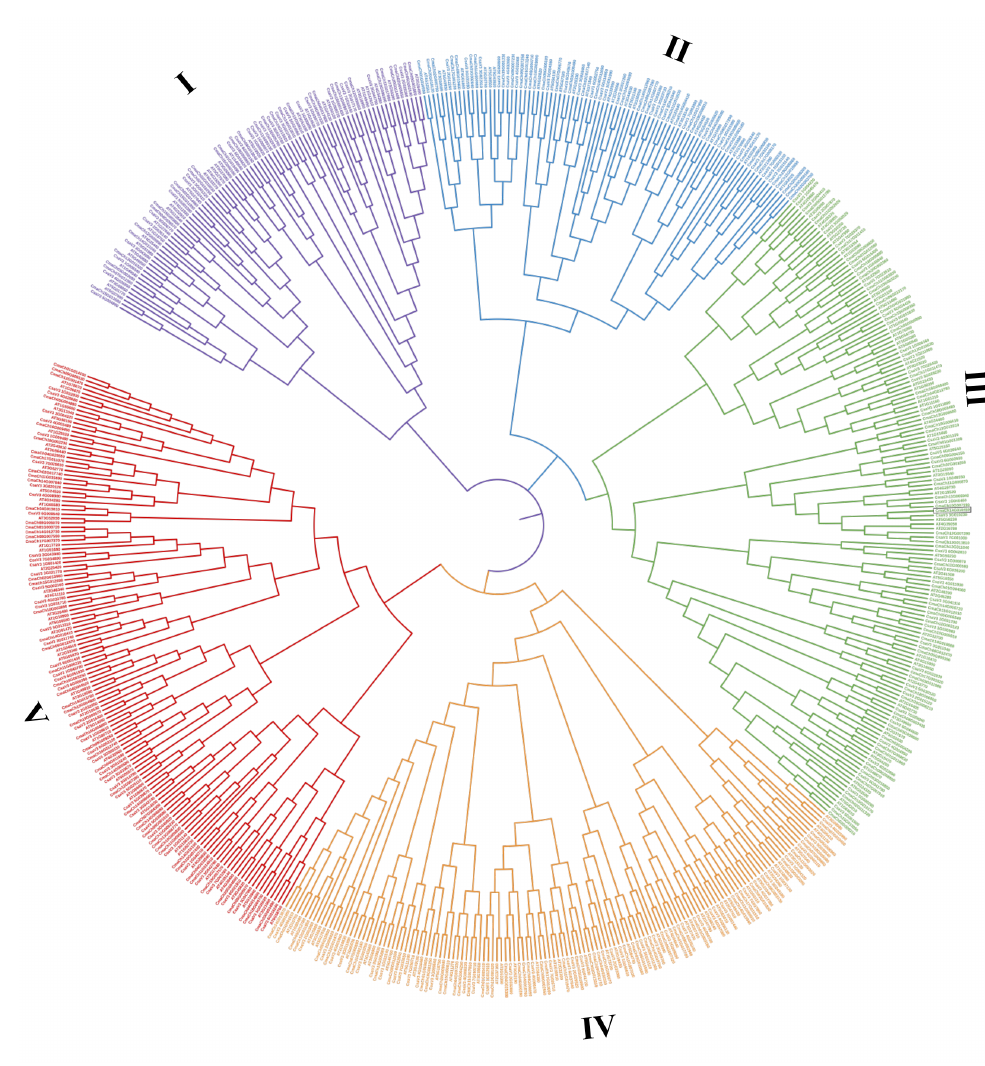
Figure 1. Phylogenetic relationships of the WD40 gene family proteins of C. maxima , A. thaliana , and C. sativus . The tree was constructed using MEGA11. The 231 C. maxima proteins, 203 A. thaliana , and 172 C. sativus proteins were divided into five clusters, labelled with different